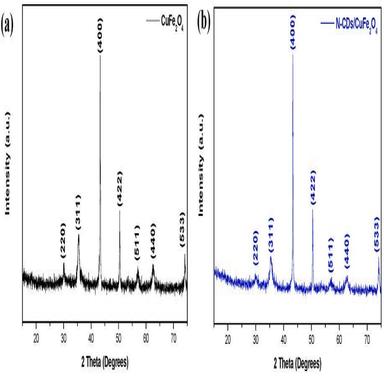
XRD spectra of (a) CuFe2O4 and (b) N-CDs/CuFe2O4. (A colour version of this figure can be viewed online.)